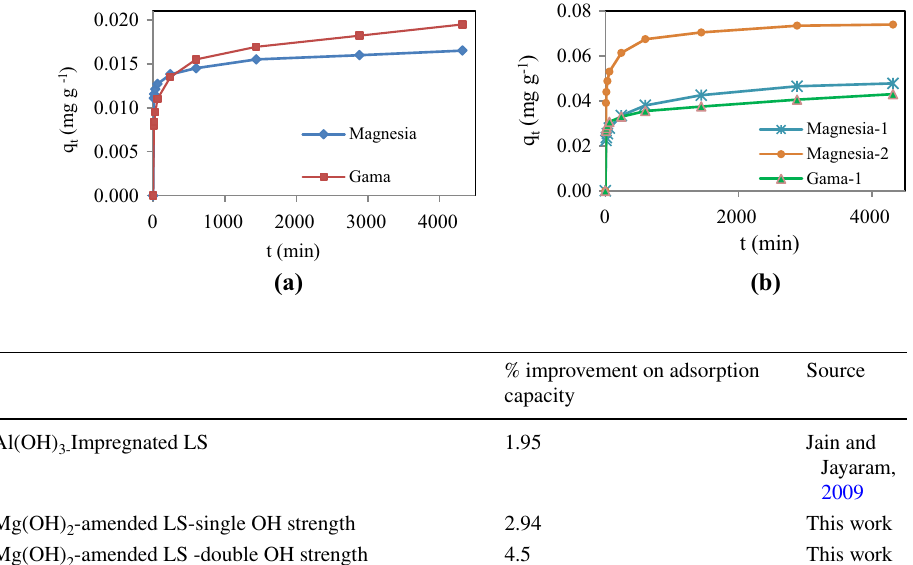
Table 3 Improvement on LS adsorption capacity due to adding OH functional group to LS